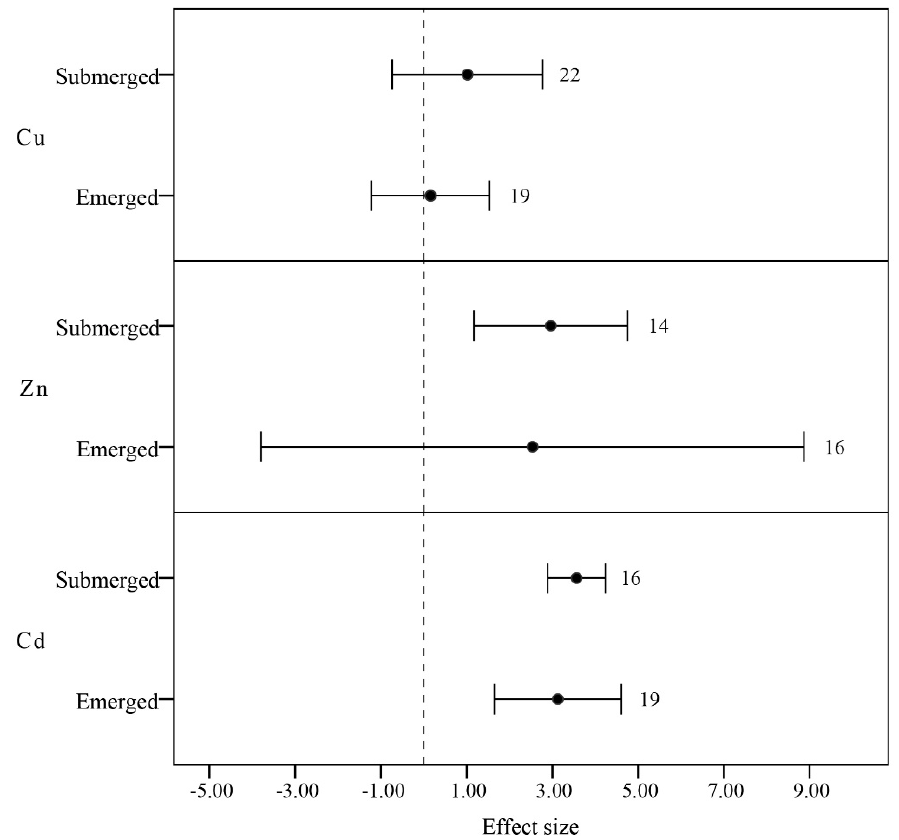
Figure 5. Mean BCF values of concentration of heavy metals Zn, Cu, and Cd on aquatic plant categorized by life habits: emerged and submerged. Error bars represent 95% bootstrapped confidence intervals (CIs). The effect of heavy metal concentration ability in aquatic plants was considered significant if the 95% CI of the effect size did not overlap with zero. The number of observations for each category is shown next to the error bars.